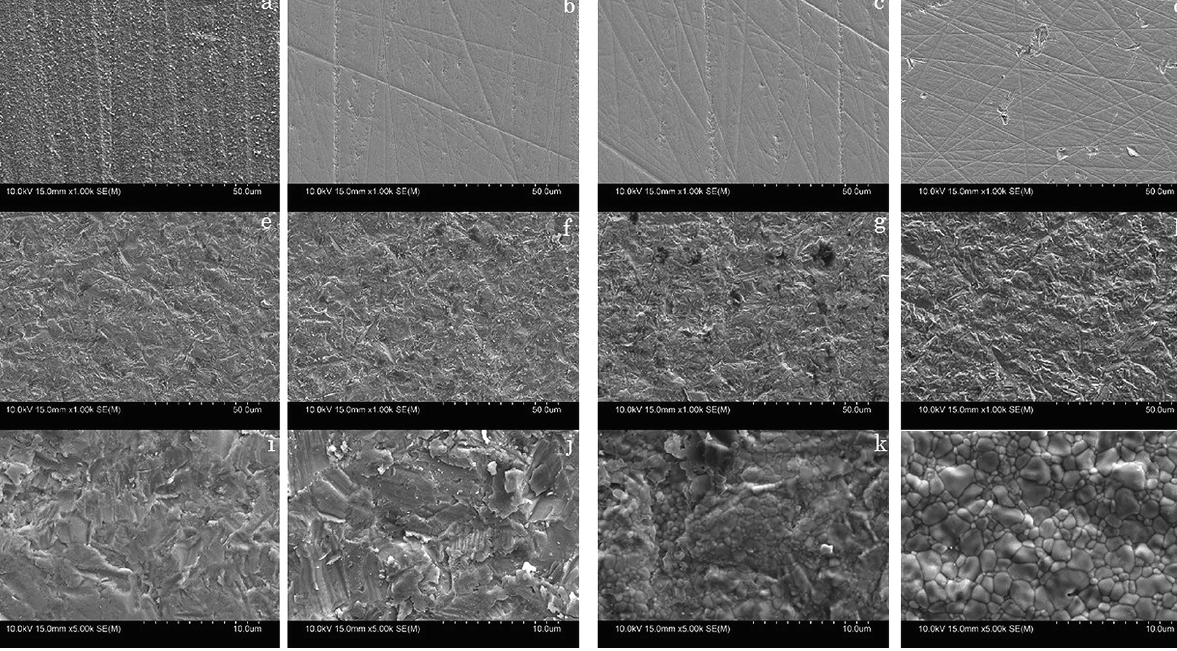
Figure 2- SEM images of highly translucent Y-PSZ after air-abrasion with alumina at different air pressures and/or with additional heat treatment: (a) as-sintered (1000×), (b) control (1000×), (c) 0.1AB (1000×), (d) 0.15AB (1000×), (e) 0.2AB (1000×), (f) 0.3 AB (1000×), (g) 0.2AB+HT0 (1000×), (h) 0.2AB+HT1h (1000×), (i) 0.2AB (5000×), (j) 0.3AB (5000×), (k) 0.2AB+HT0 (5000×), (l) 0.2AB+1h